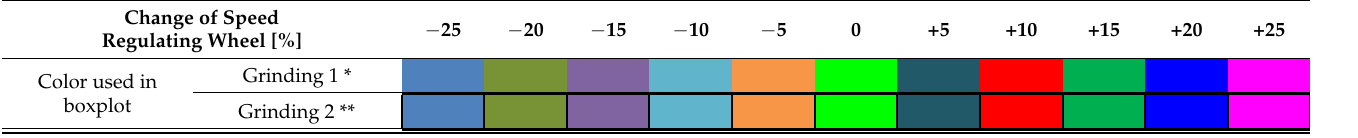
Table 5. Color coding of the different grinding modes.